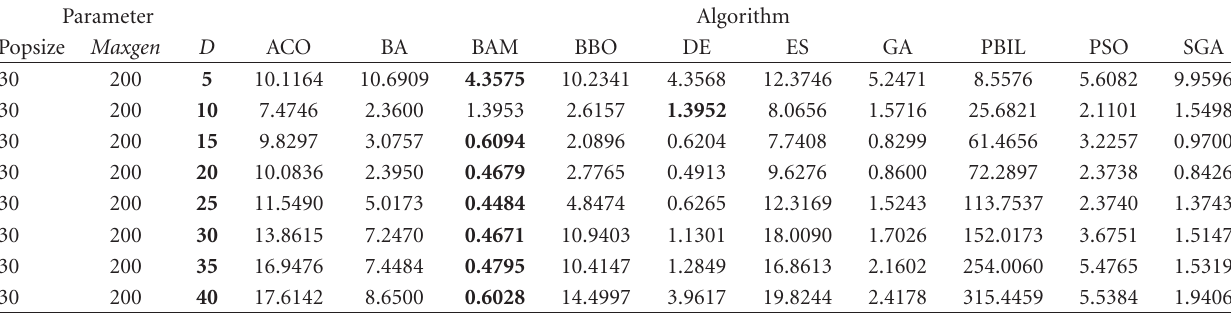
Table 6: Best normalized optimization results on UCAV path planning problem on di ff erent D . The numbers shown are the best results found after 100 Monte Carlo simulations of each algorithm.